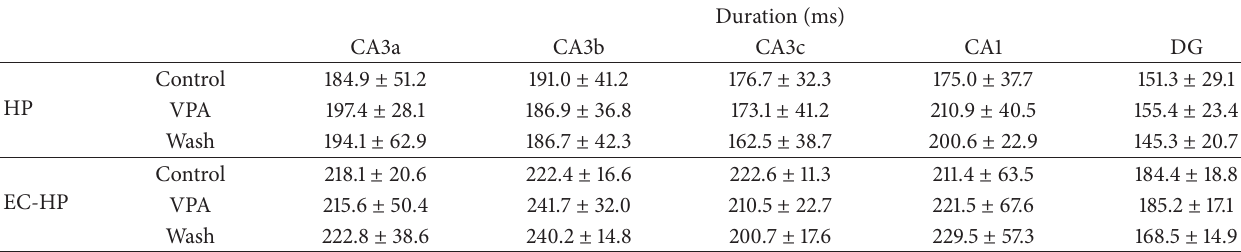
Table 3: Statistical analysis results of VPA effects on the duration of interictal discharges in the two slice models (mean ± SEM, 𝑛 = 5 ).